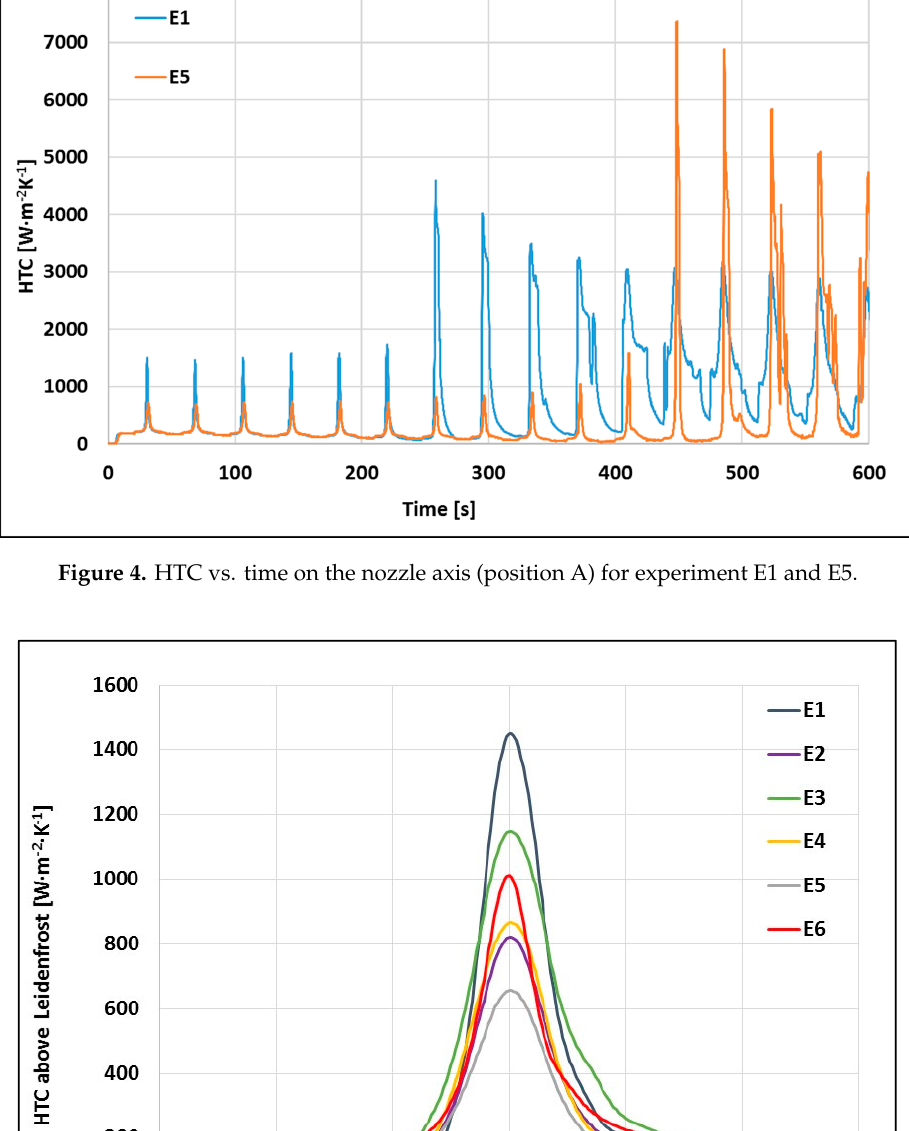
Figure 3. Temperatures measured at a depth of 2 mm and computed surface temperatures, data for experiments E1 and E5 in position of nozzle axis.